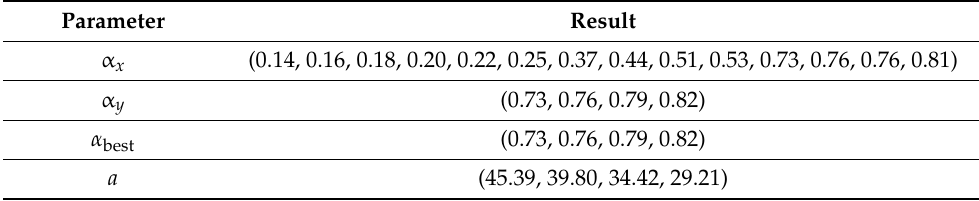
Table 1. The determined best orders α best and width a of fringe patterns.